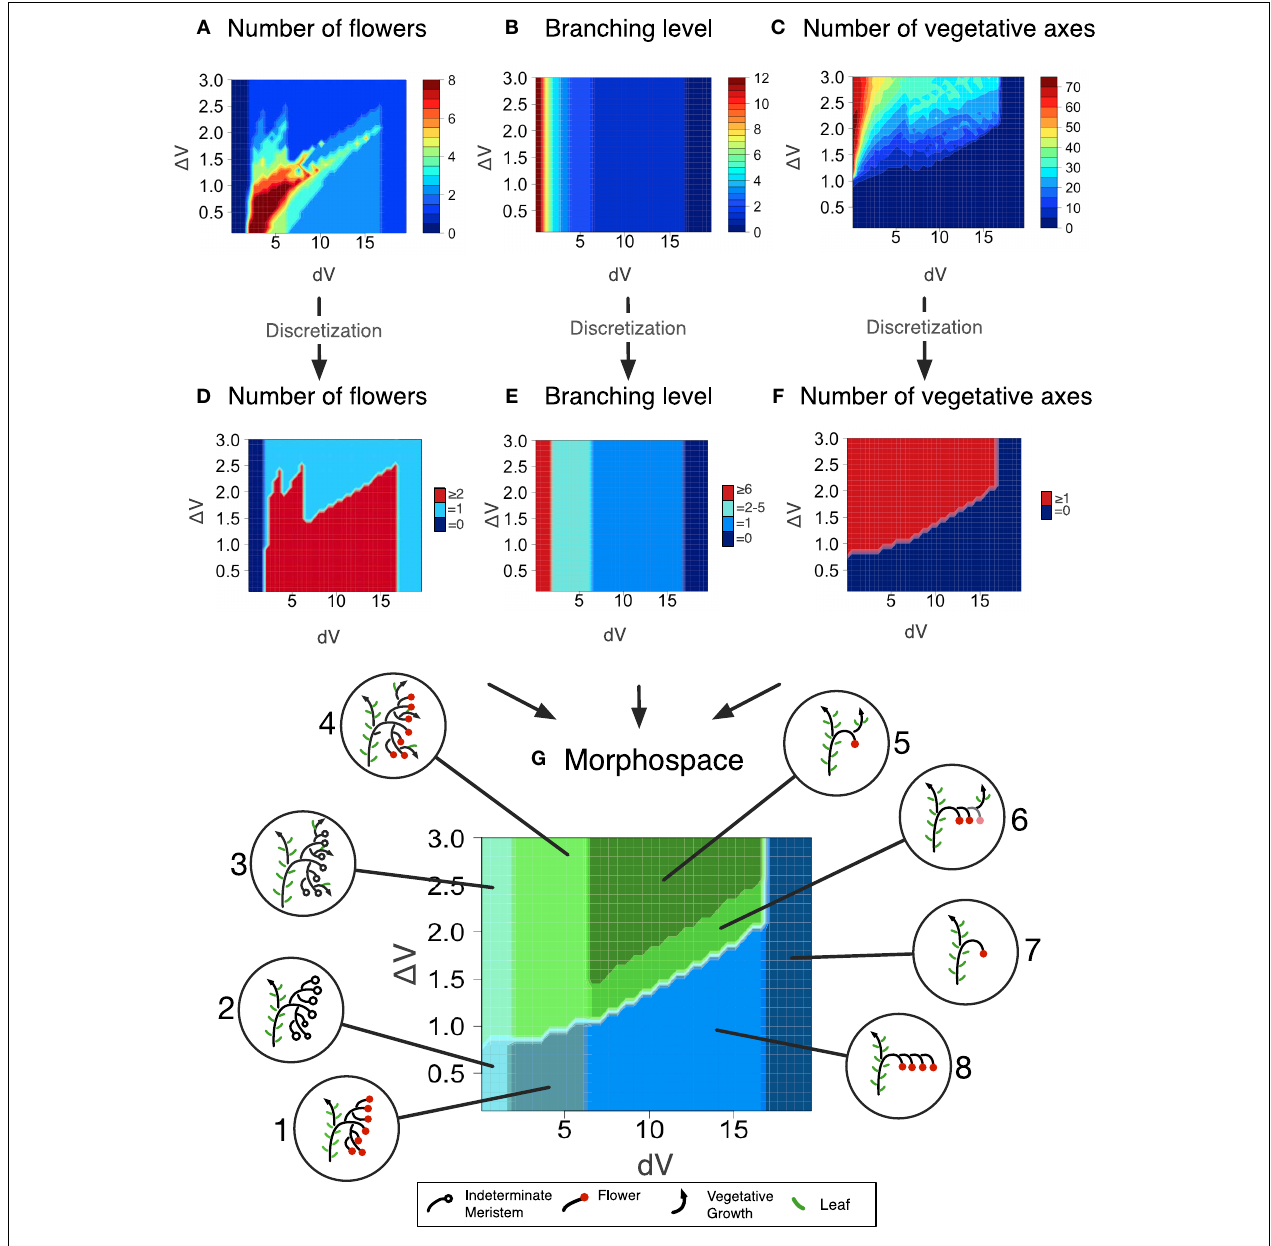
FIGURE 4 | Morphospace obtained for a range of dV and (cid:2) V values after floral transition (0 > dV > 20 and 0 > (cid:2) V > 3). Inflorescences generated by the mathematical model were characterized by: (A) The number of flowers; (B) The branching level; (C) The number of vegetative axes. (D) Discretization of (A) in three classes (0 / 1 / ≥ 2).